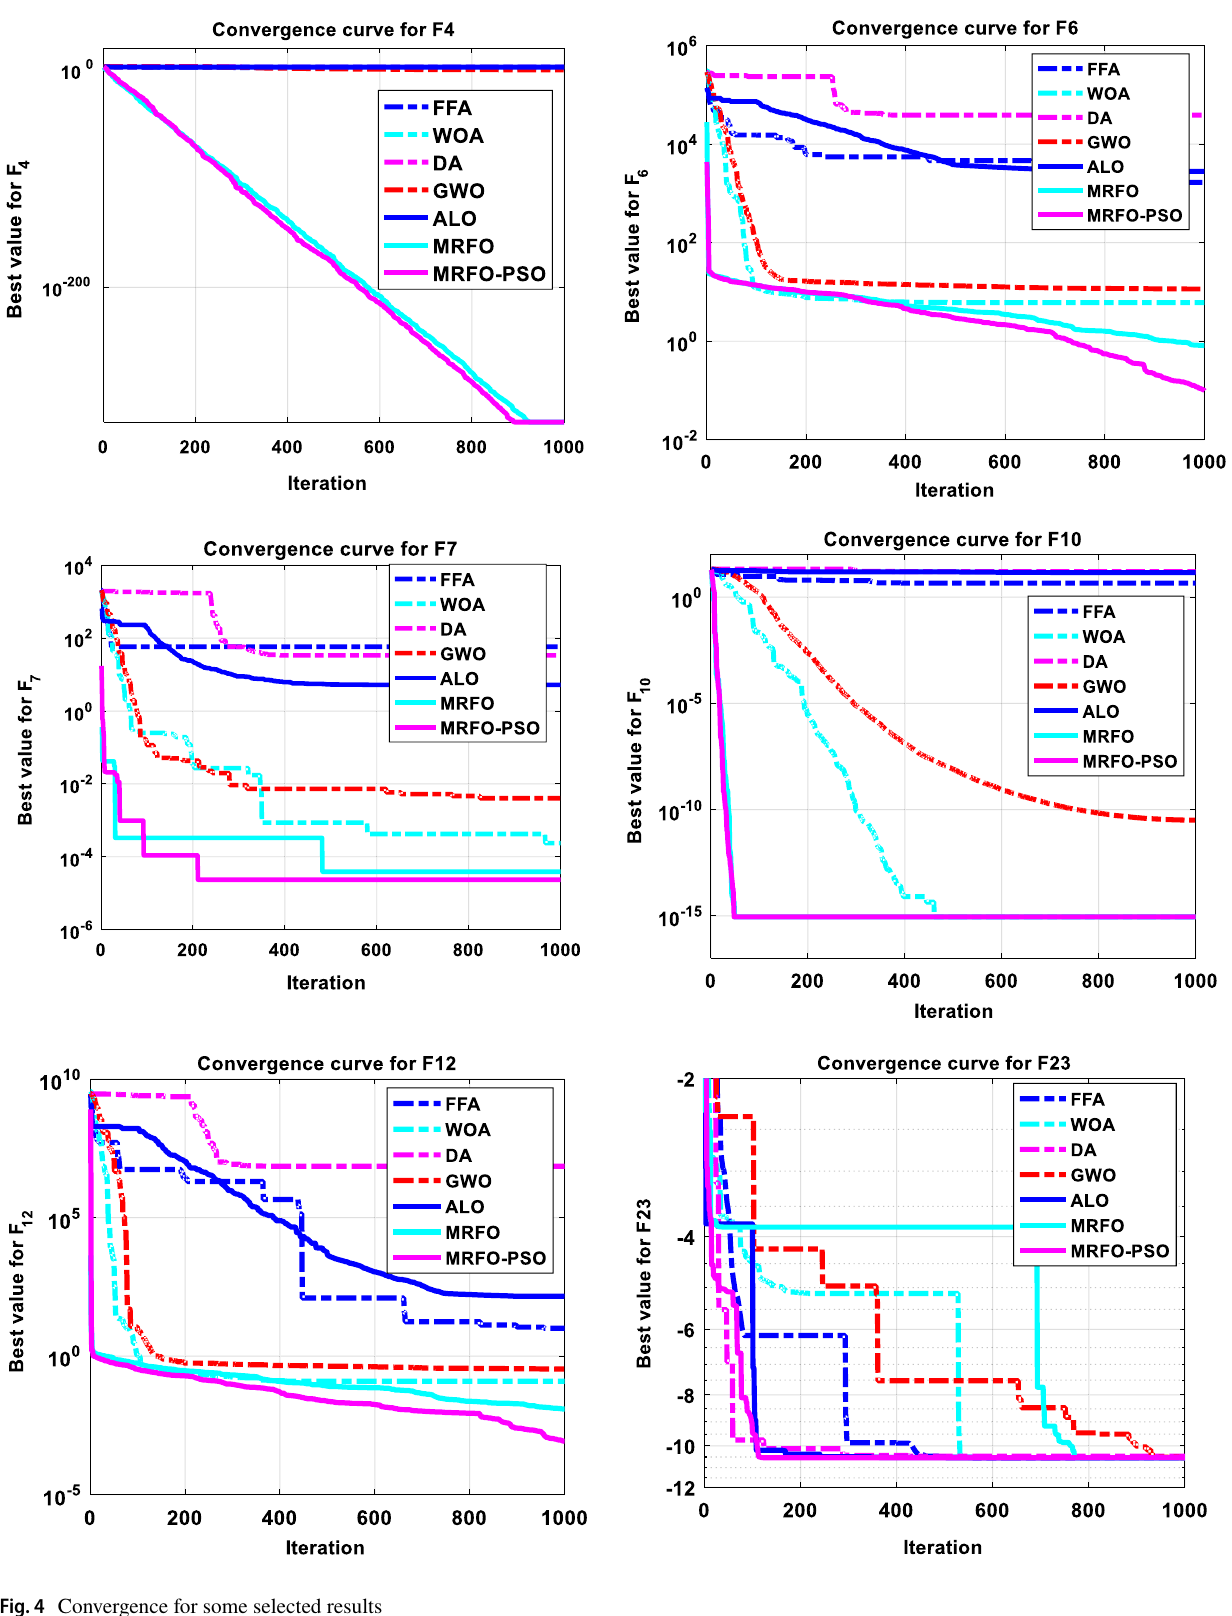
Fig. 4 Convergence for some selected